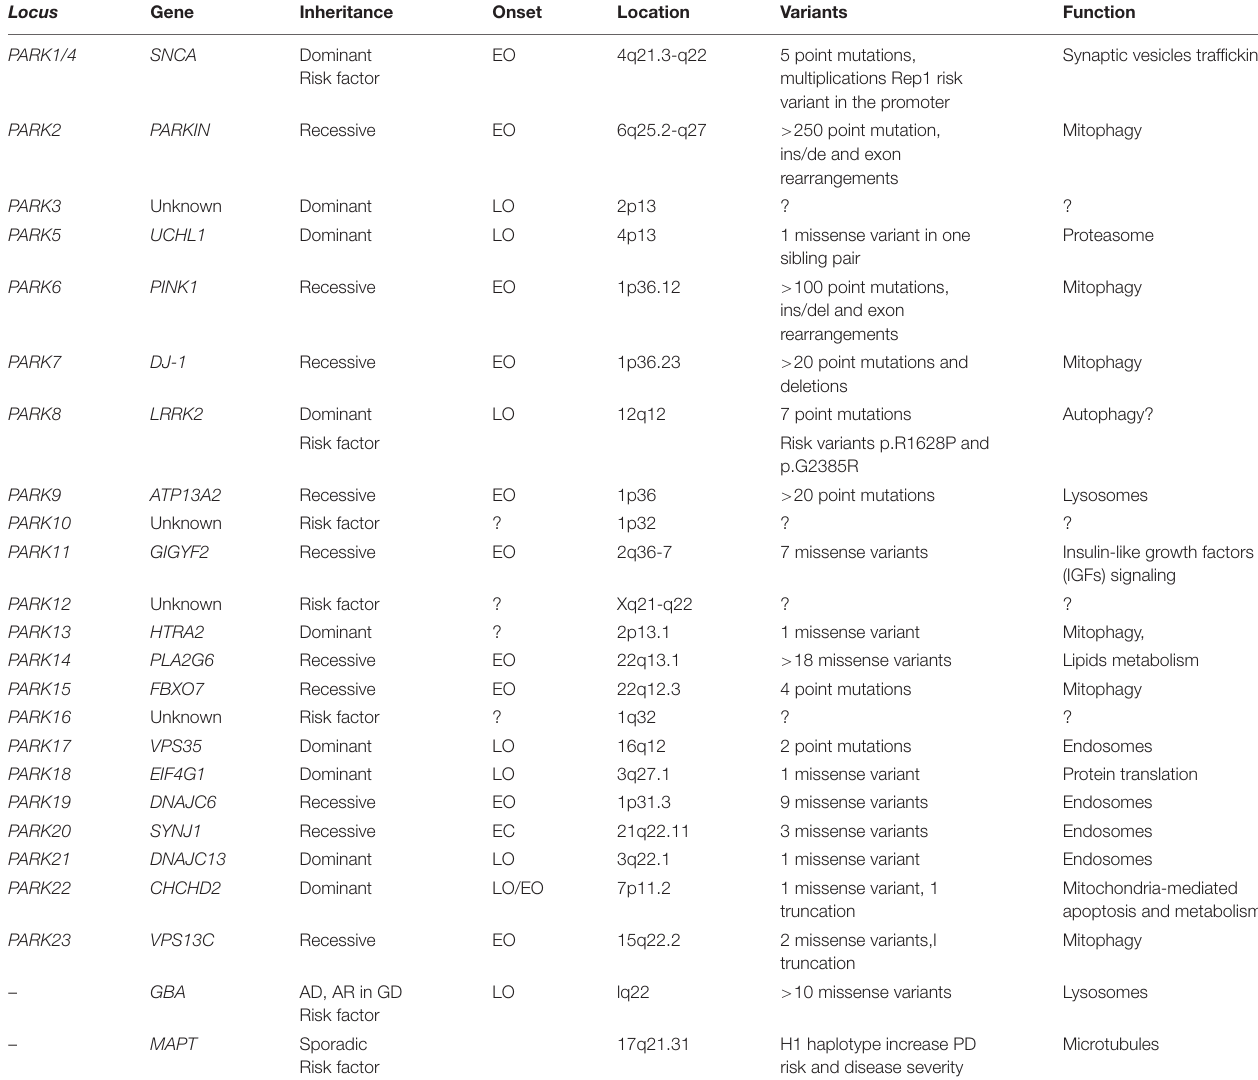
TABLE 1 | Summary of genes associated with Parkinson’s disease. Locus Gene Inheritance Onset